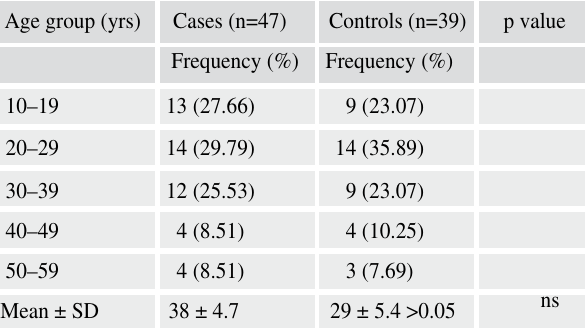
Table I: Distribution of subjects according to age